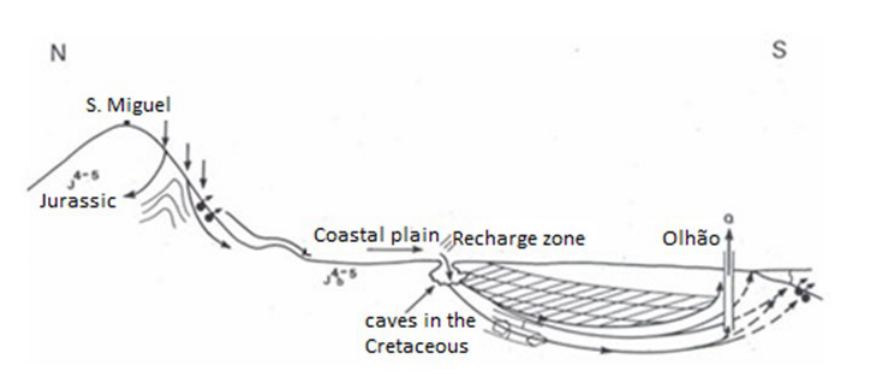
Figure 4: Detail of hydraulic relations between limestone hills and littoral flat lands, northeast